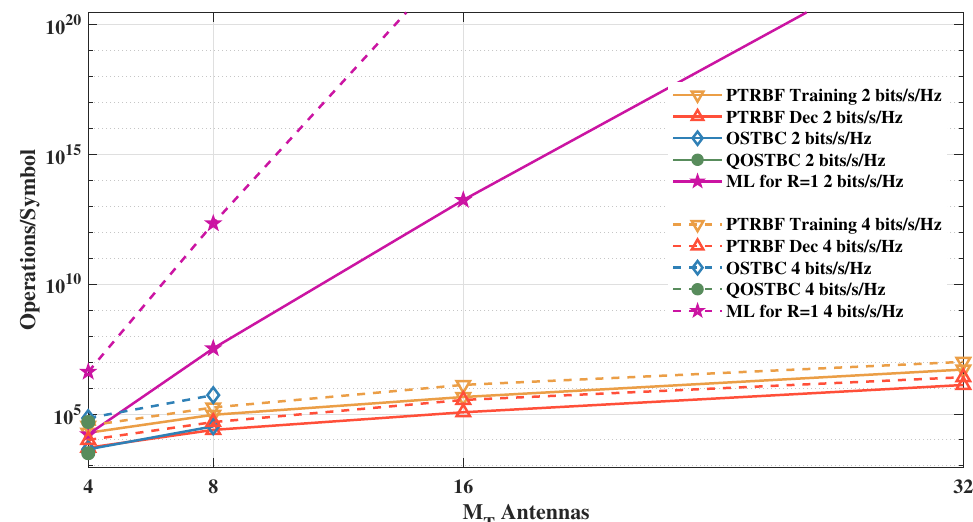
Figure 25. Computational complexities as a function of M T = M R